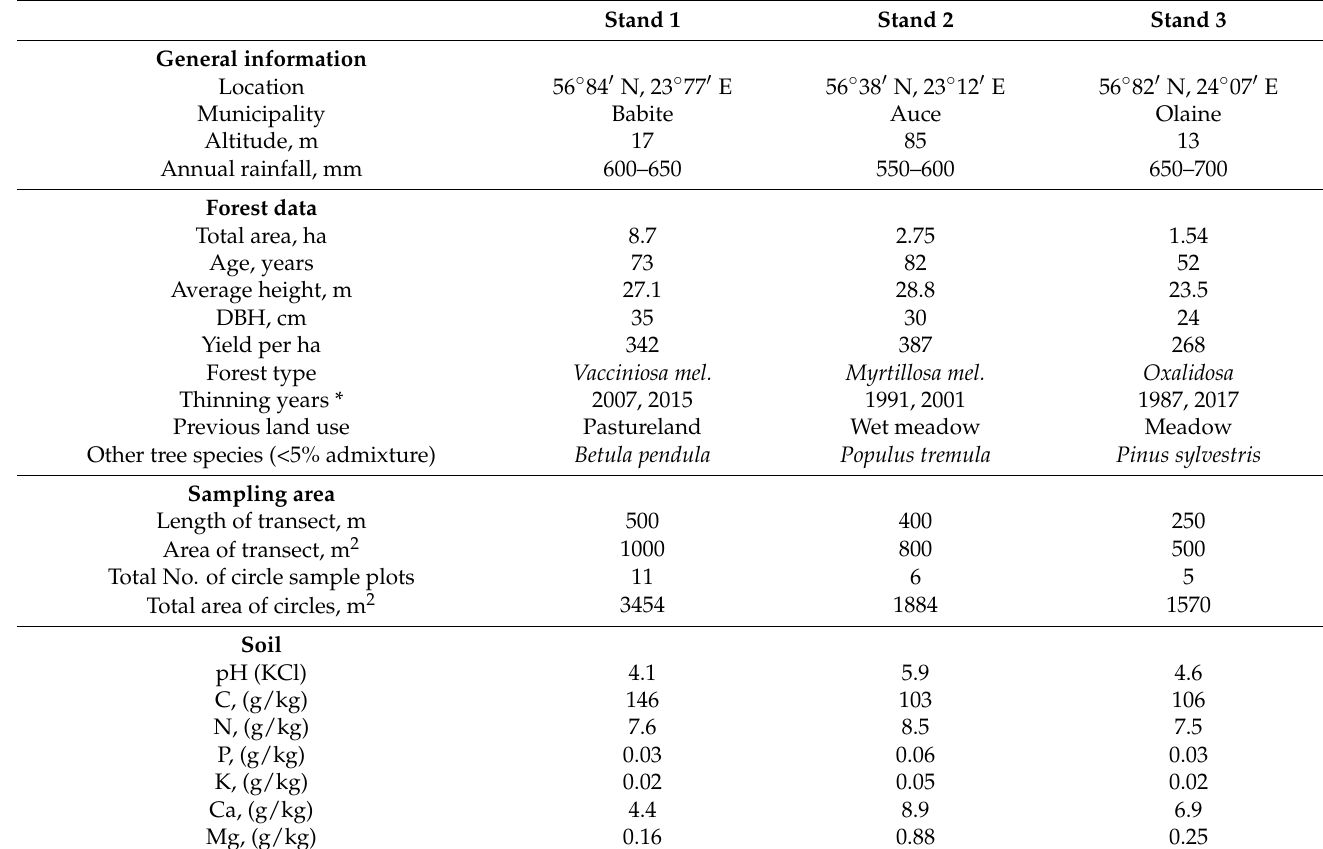
Table 1. Description of Norway spruce stands selected for the study: general information, forest characteristics, and details of sampling area and soil parameters. Stand 1 Stand 2 Stand